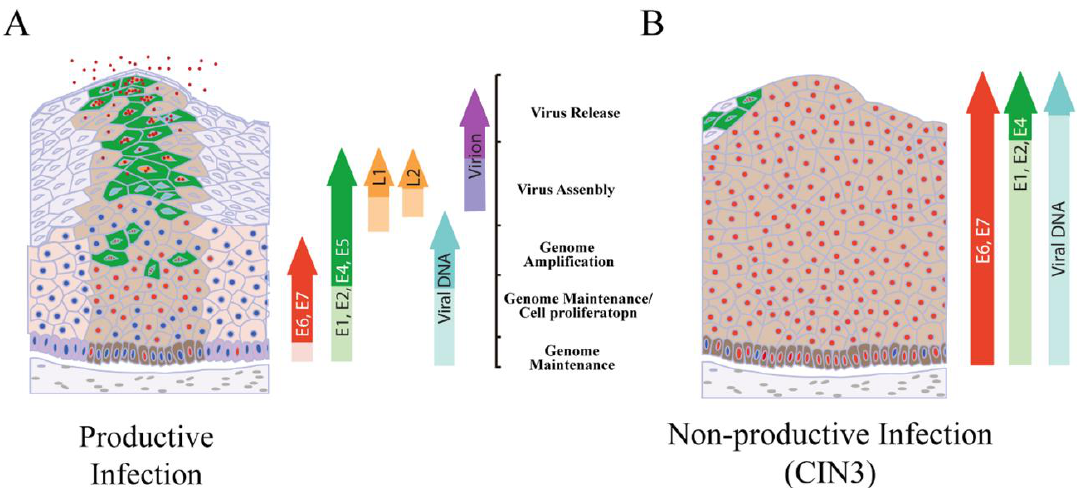
Figure 4. Regulation and deregulation of the high-risk Alphapapillomavirus life cycle. ( A ) The papillomavirus life cycle is regulated during epithelial cell differentiation and is shown diagrammatically. Cells that are driven through the cell cycle as a result of E6 and E7 expression are marked with red nuclei. The up-regulation of viral proteins necessary for genome amplification ( i.e. , E1 and E2) requires activation of the viral late promoter in the upper epithelial layers (cells shown in green with red nuclei), with virus particles subsequently being released from the epithelial surface; ( B ) In HPV-associated neoplasia, late gene expression is retarded, and although the order of events remains the same, the production of infectious virions is restricted to smaller and smaller areas close to the epithelial surface. This situation is thought to be accompanied elevated E6/E7 expression, and represents a non-productive or poorly productive abortive infection. Integration of HPV DNA into the host cell genome is facilitated by deregulated E6/E7 expression. If integration disrupts the E1/E2 region this can allow the persistent high-level expression of E6 and E7 and the accumulation of genetic errors in the host genome. Eventually, the productive virus life cycle is no longer supported and viral episomes are lost (reviewed in [83]).